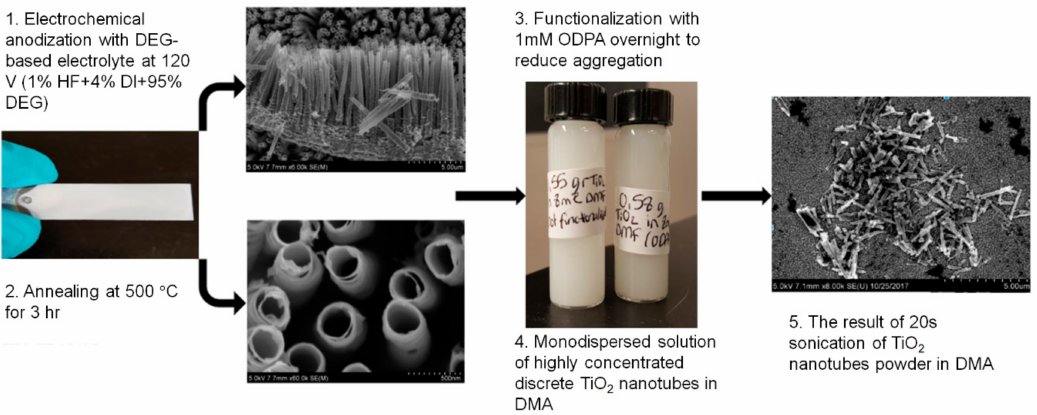
Figure 2. Discrete TiO 2 NT synthesis, functionalization, and discretization methods